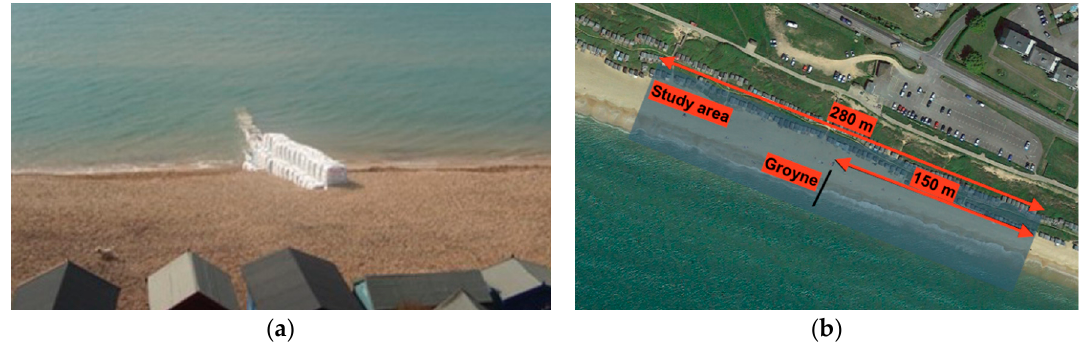
Figure 10. ( a ) View of the temporary structure from the top of Hordle Cliff the 6 October 2007; ( b ) plan view of the study site and groyne position.